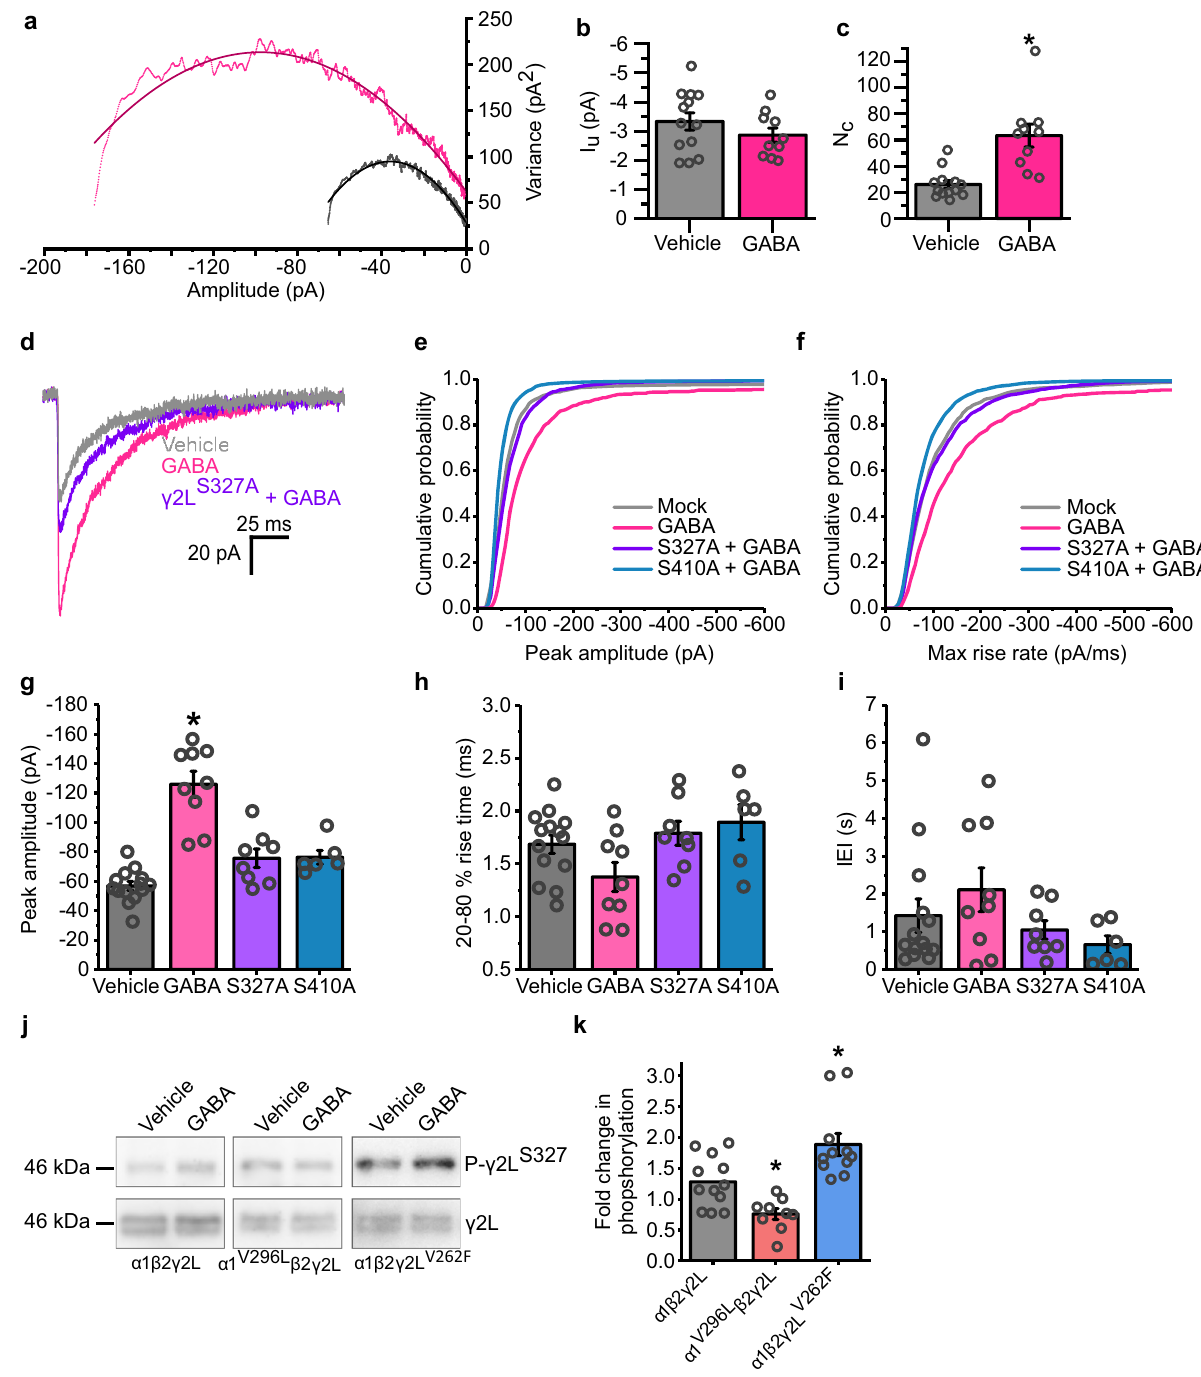
(with picrotoxin), or by ablating the sites of PKC phosphorylation on β 2 S410A or γ 2 S327A